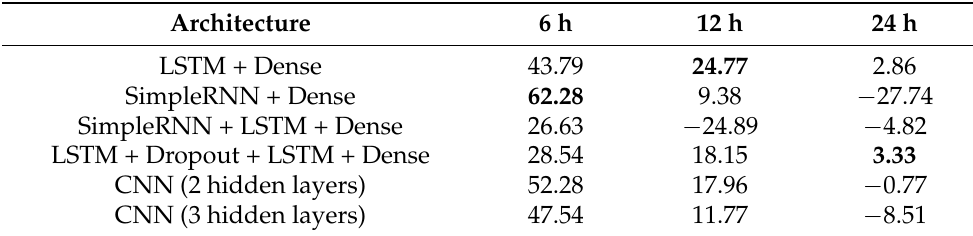
Table 8. Summary of the evaluated approaches in terms of the percentage of RMSE improvement with respect to the ARIMA for different time horizons. The best performance for each time horizon is marked in